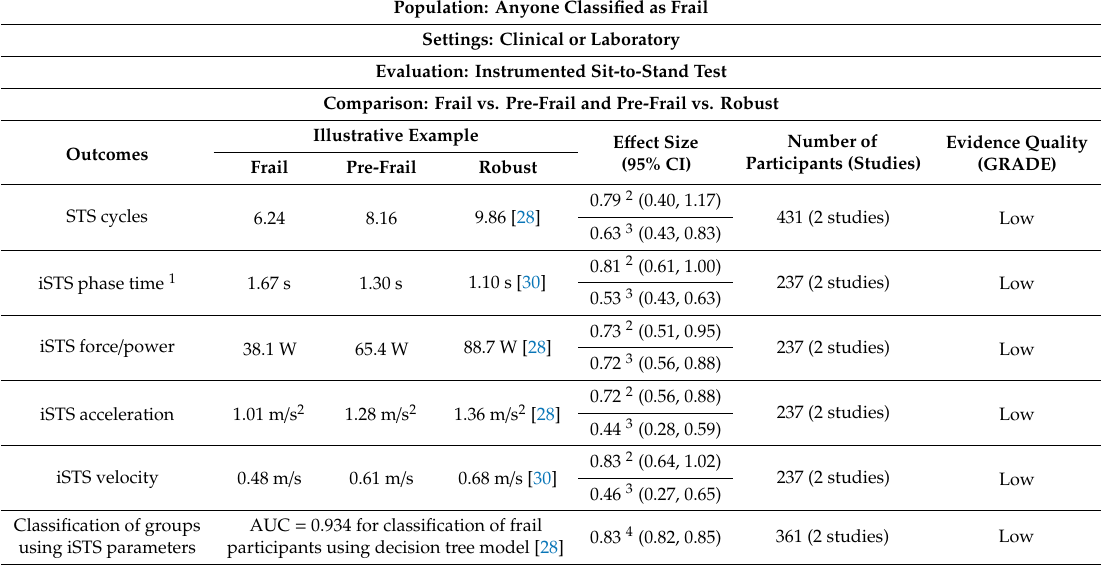
Table 4. Summary of findings for comparisons by frailty